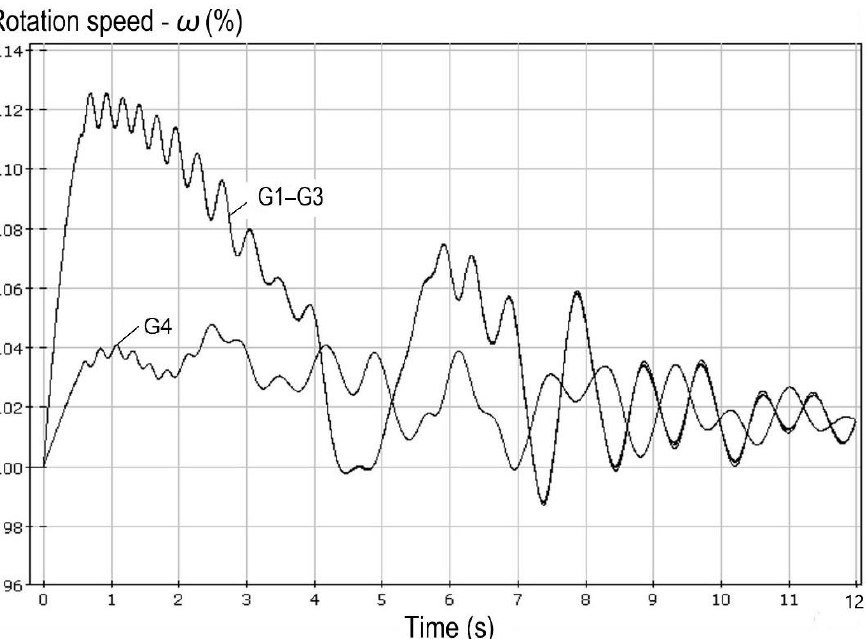
Figure 6. A transient process similar to that in Figure 3 but with an 80% share of induction motors at load nodes.